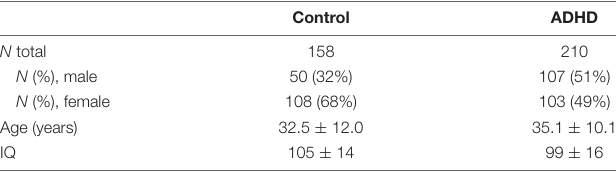
TABLE 1 | Demographic data at baseline (t 1